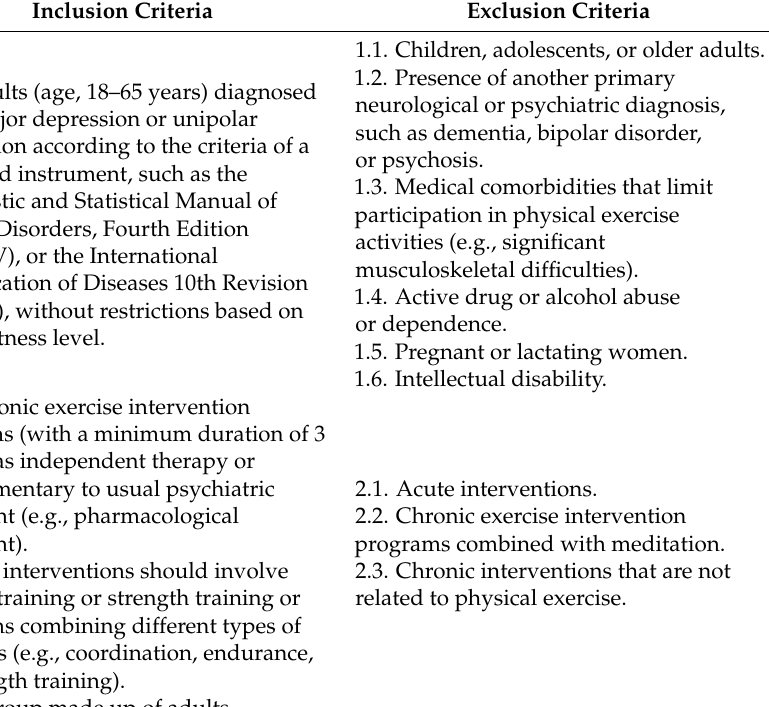
Table 1. Eligibility Criteria Based on PICOS. PICOS Inclusion Criteria Exclusion